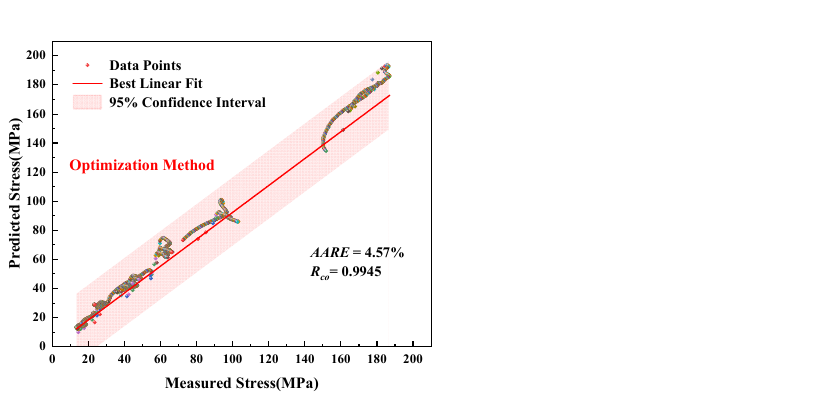
Figure 9. The comparison between the experimental data and predicted data of the modified JC model at different strain rates: ( a ) 0.01 s − 1 ; ( b ) 0.1 s − 1 ; ( c ) 1 s − 1 ; and ( d ) 10 s − 1 .